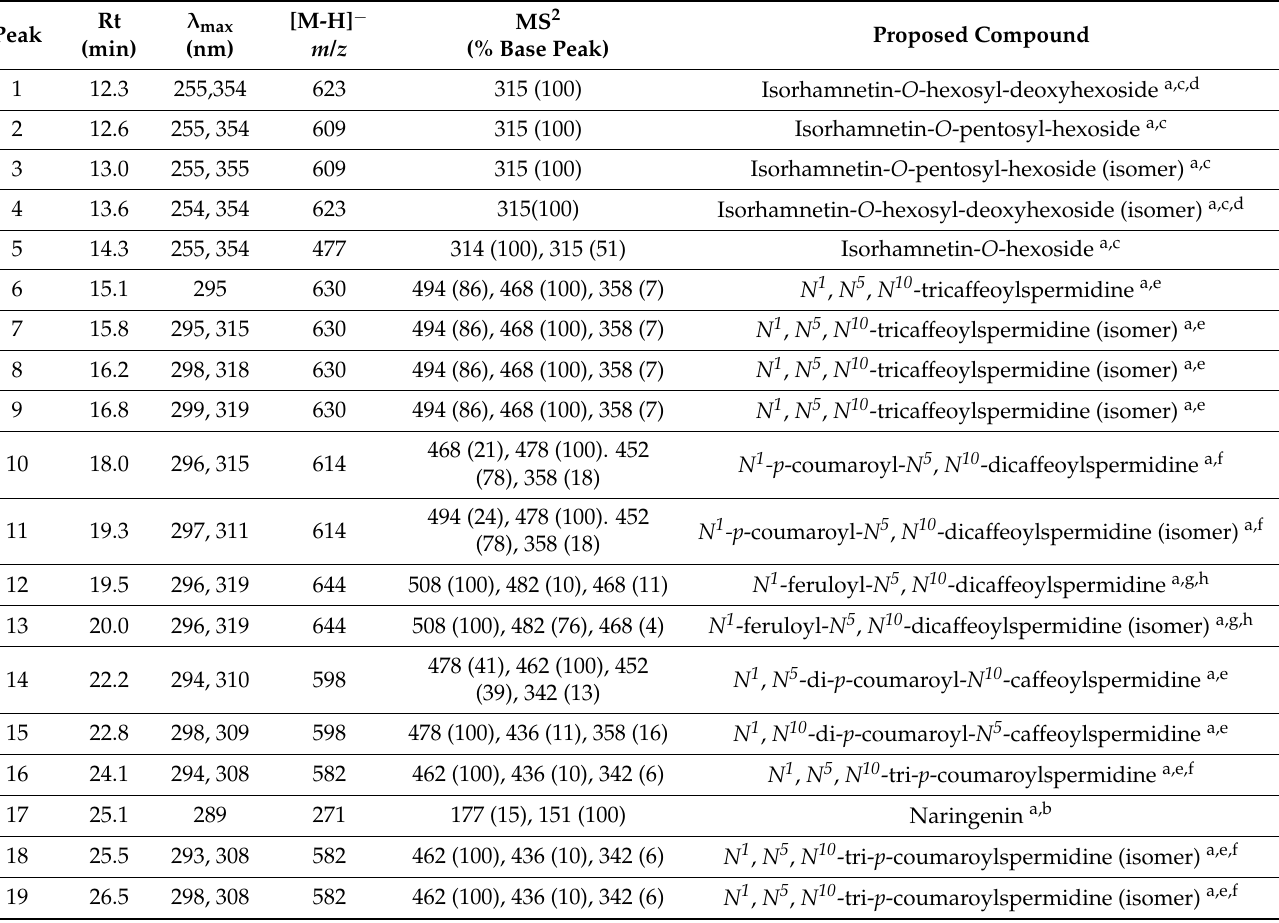
Table 1. Retention time (Rt), wavelengths of maximum absorption in the visible region ( λ max ), mass spectral data, and proposed phenolic and phenolamide compound identification in Castanea pollen loads.